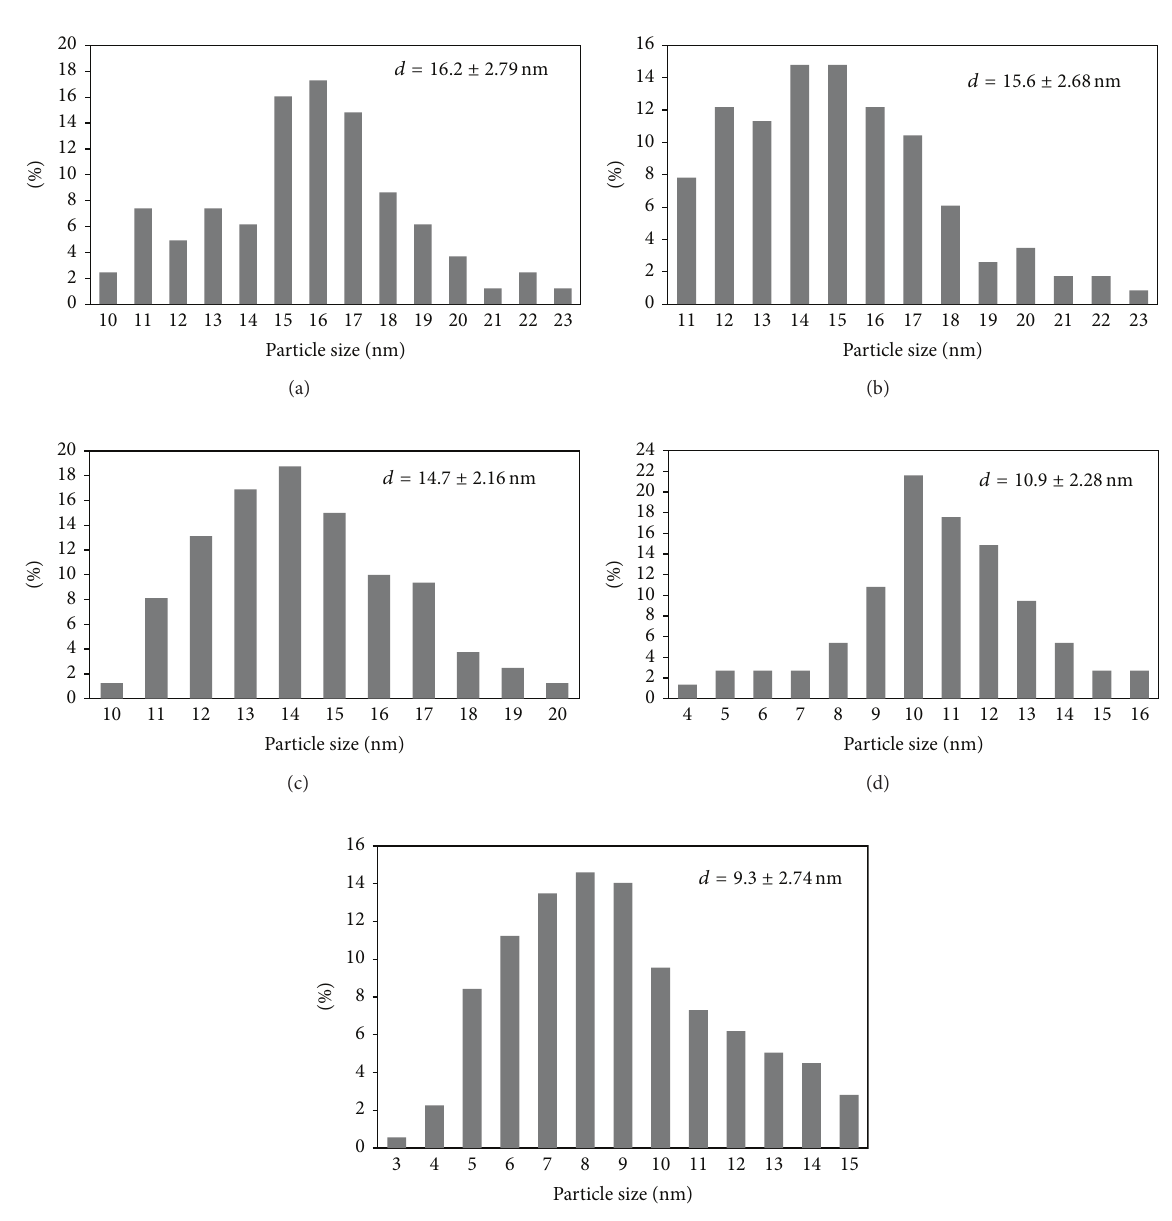
Figure 3: Particle size distribution of maghemite nanoparticles for samples: (a) MNA2, (b) MNA4, (c) MNA6, (d) MNA8, and (e)